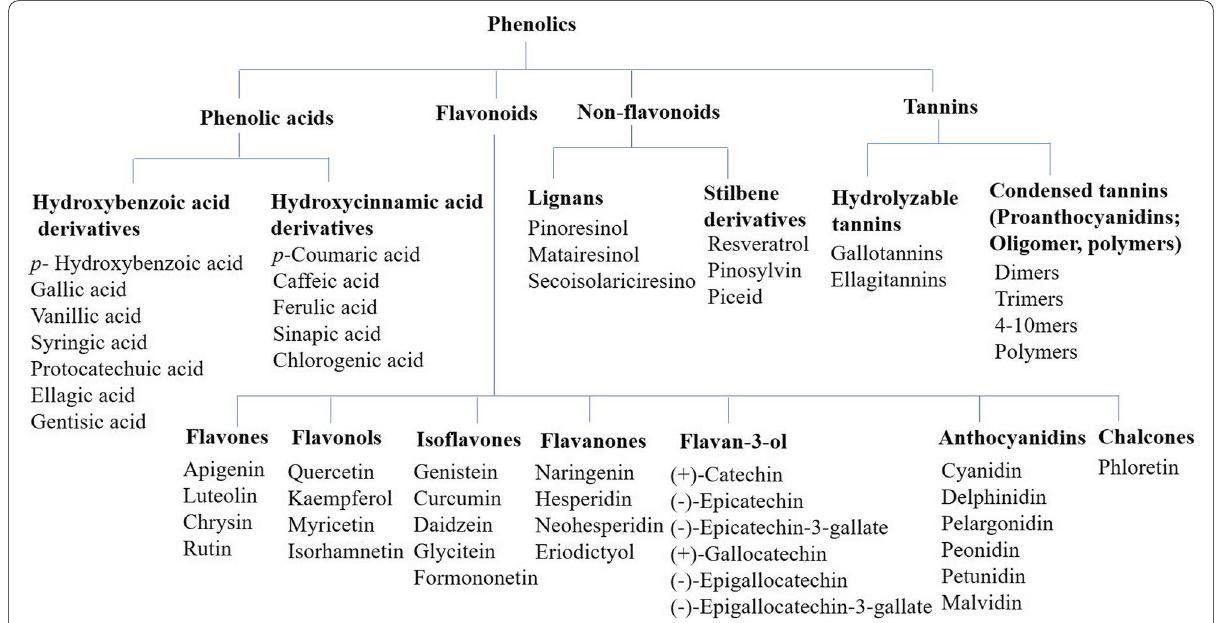
Fig. 1 Schematic representation of classification of phenolic compounds (Adapted from Shahidi & Ambigaipalan 2015; Vardhan & Shukla